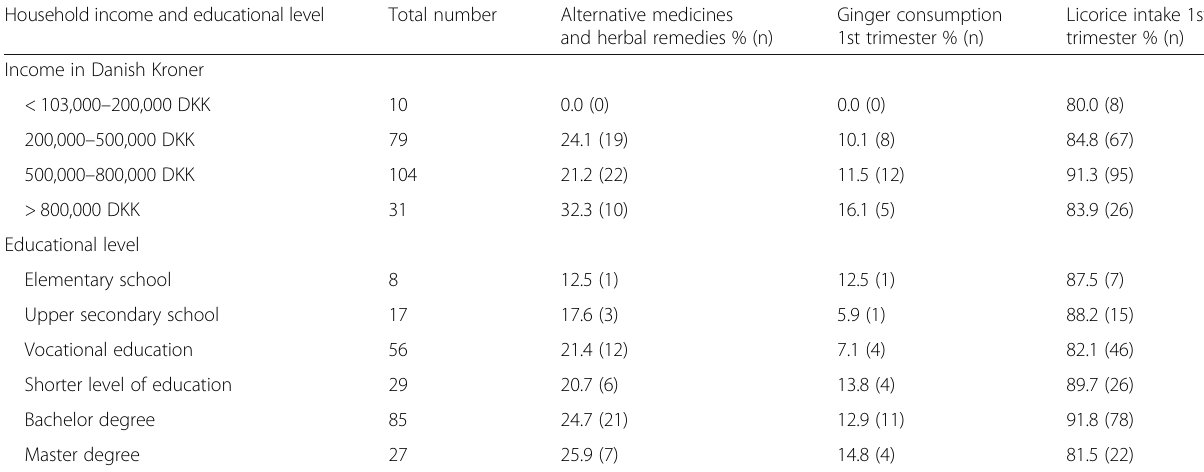
Table 2 Household income, educational level and nutritional habits